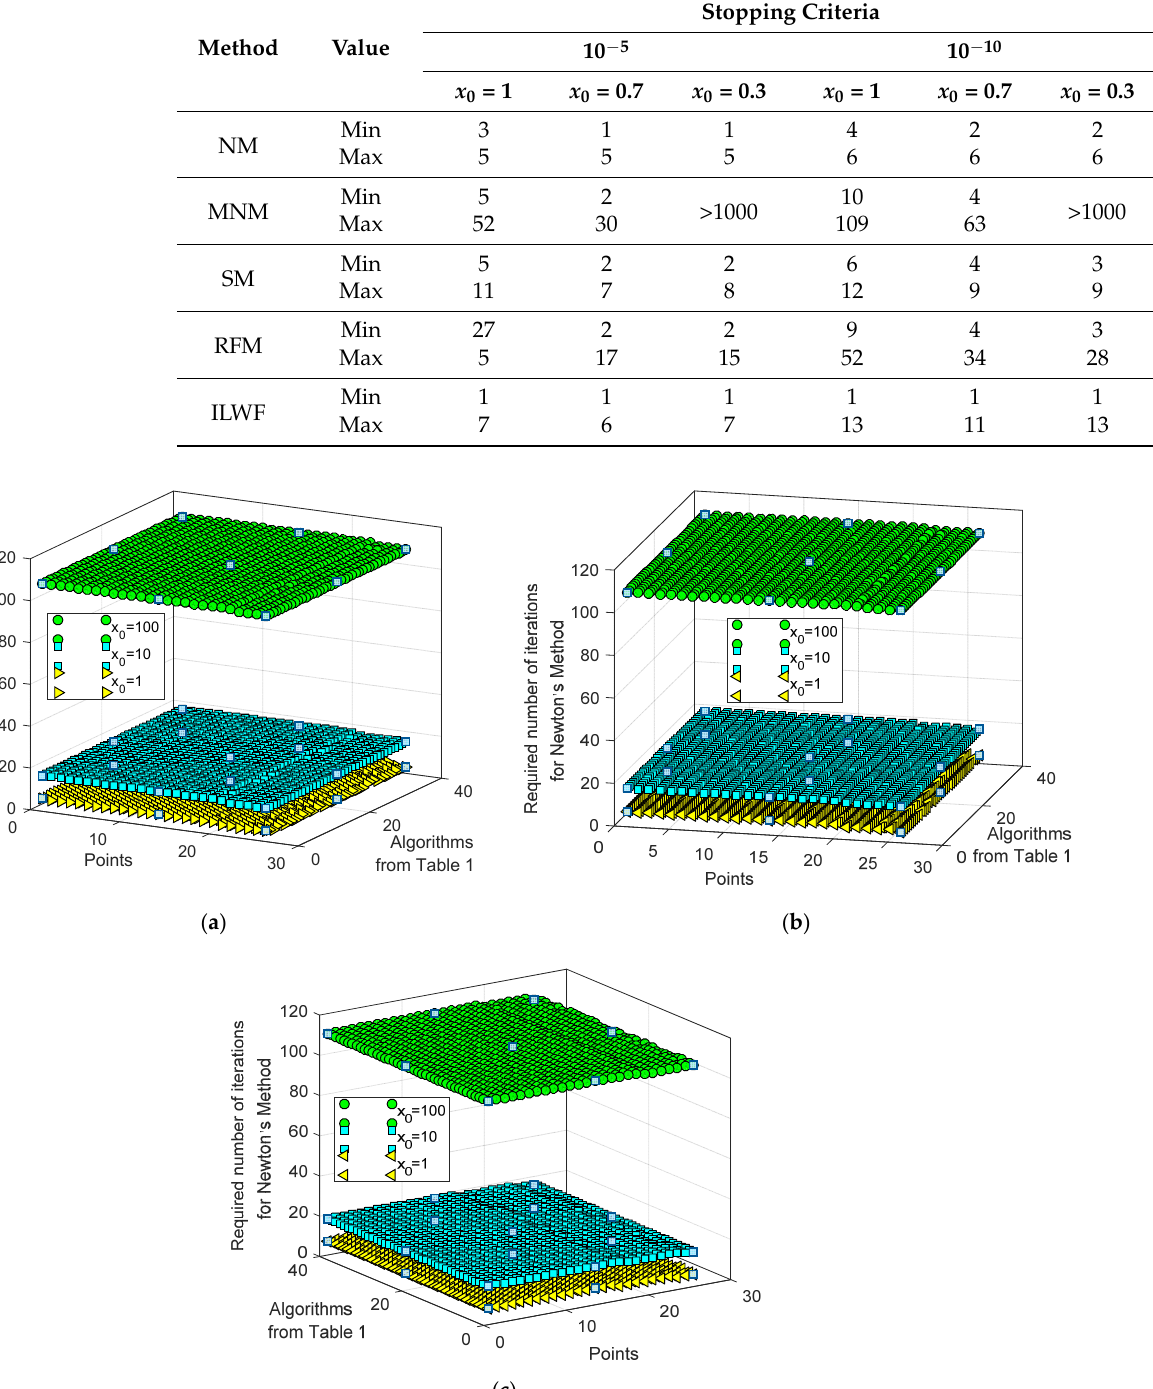
Table 4. Minimum and maximum number of iterations for the used iterative methods observing all measured points of RTC France solar cell.